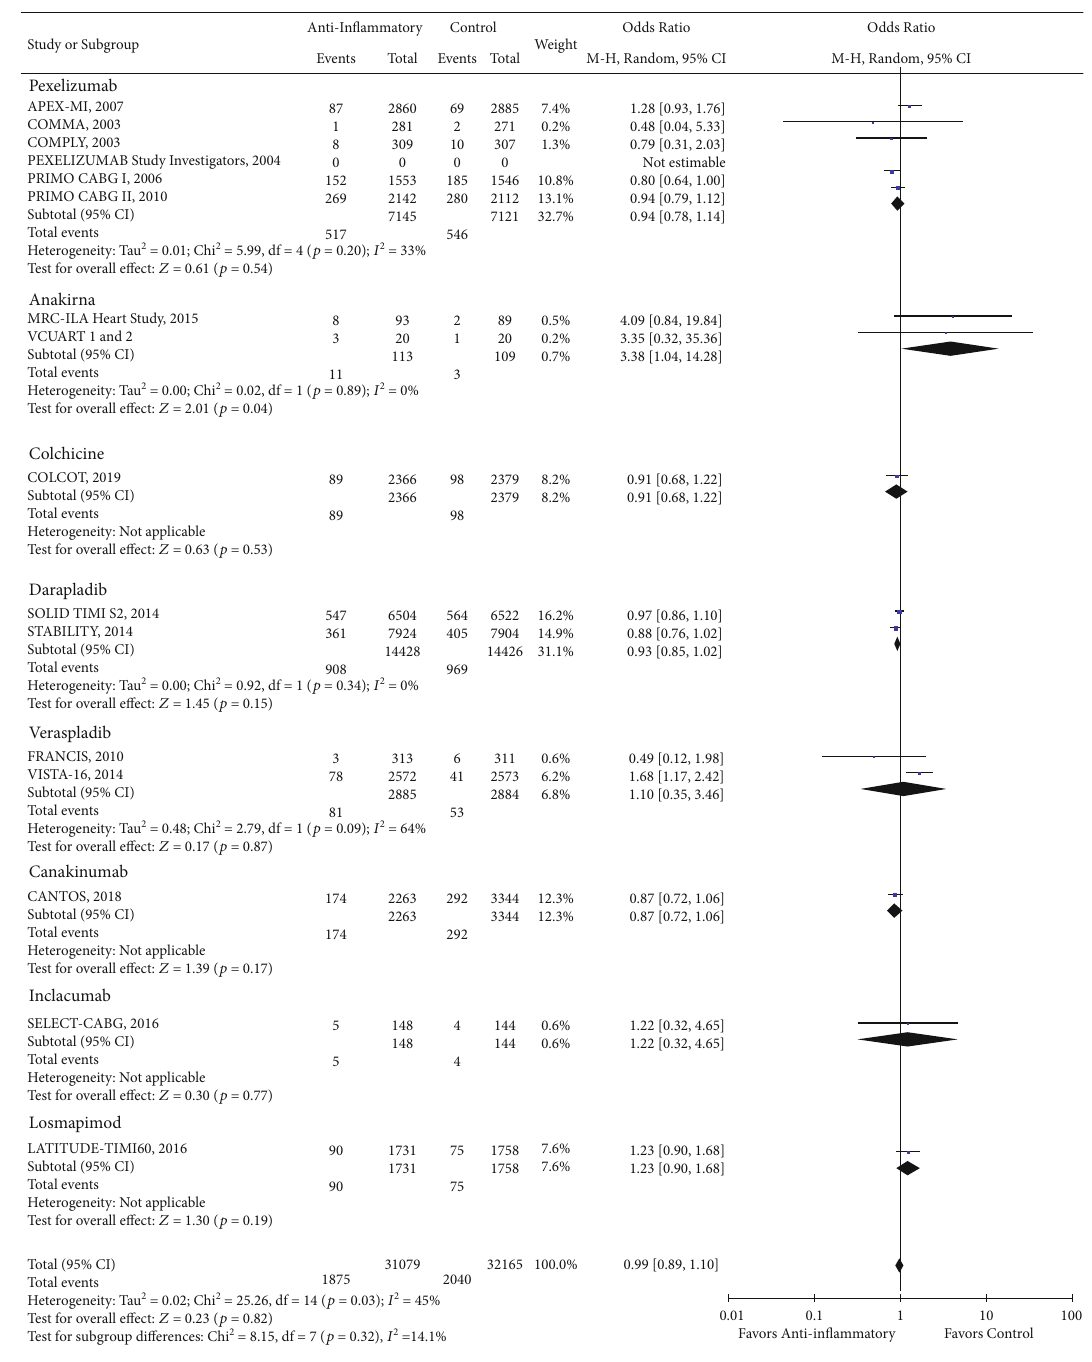
Figure 6: Forest plot of recurrent myocardial infarction. No signi fi cant di ff erence was observed between anti-in fl ammatory therapy and standard therapy in terms of recurrent myocardial infarction (OR 0.99, CI 0.89-1.10; P = 0 : 82